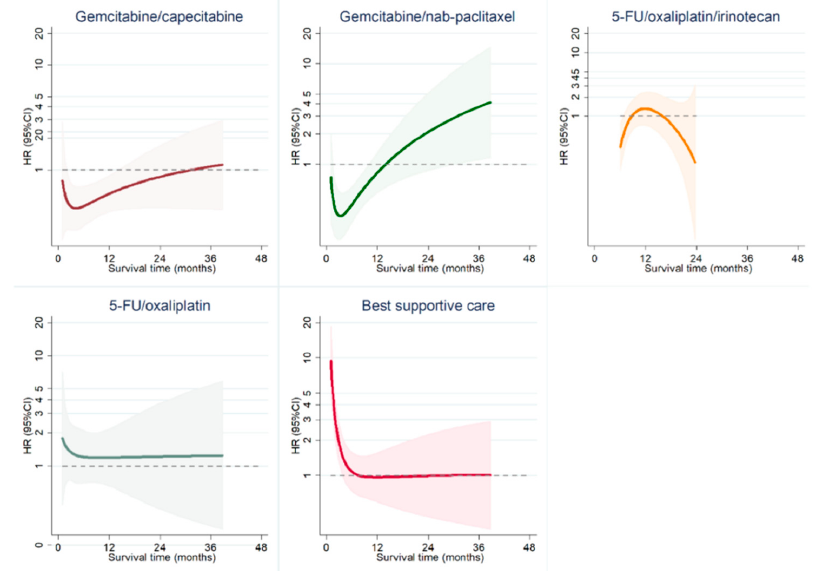
Figure 2. Flexible parametric survival models for HR for death compared to treatment with gemcitabine. All models were adjusted for sex (male or female), age (continuous), BMI (continuous), alcohol consumption (no, current, previously, or unknown), smoking (no, current, previously, or unknown), diabetes (no, yes, or unknown), surgery (no, yes, or unknown), bile duct stenting (no, yes, or unknown), tumor stage (IA/IB/IIA/IIB/III vs. IV), tumor grade (0, 1, 2+), ECOG level (0, 1, 2, 3, or unknown), and CA19-9 level (quantile). Patients taking 5-FU/oxaliplatin/irinotecan were followed up for 24 months because the 95%-CI was large after 24 months. Error bands indicate the 95%-CI.